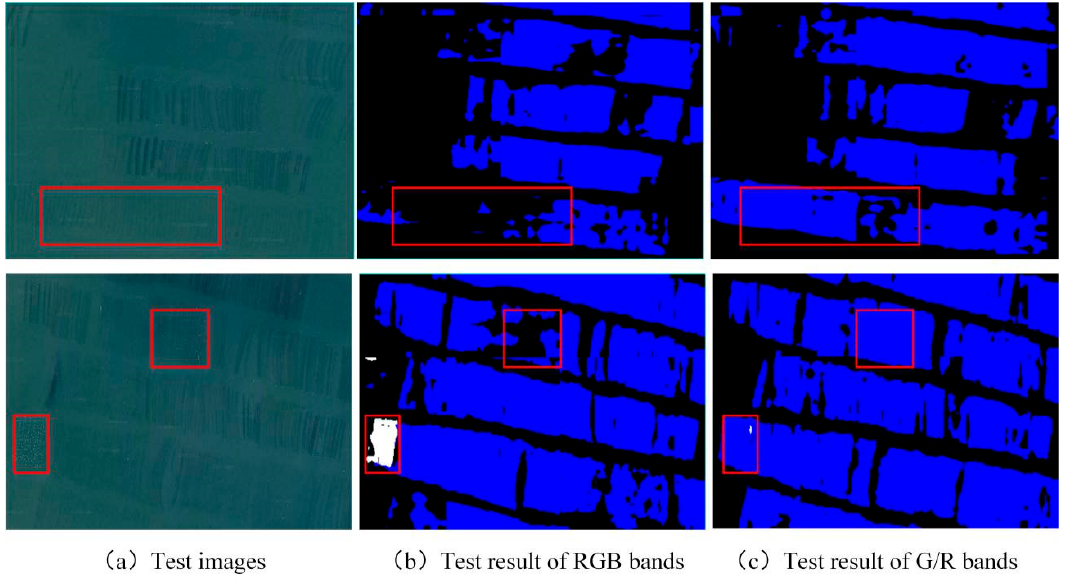
Figure 12. ( a ) The test images; ( b ) prediction result of RGB data training model; ( c ) prediction result the ratio band(G / R) data training model (black is the background, white is fish row cage aquaculture, of the ratio band(G/R) data training model (black is the background, white is fish row cage and blue is floating raft aquaculture, and blue is floating raft aquaculture).